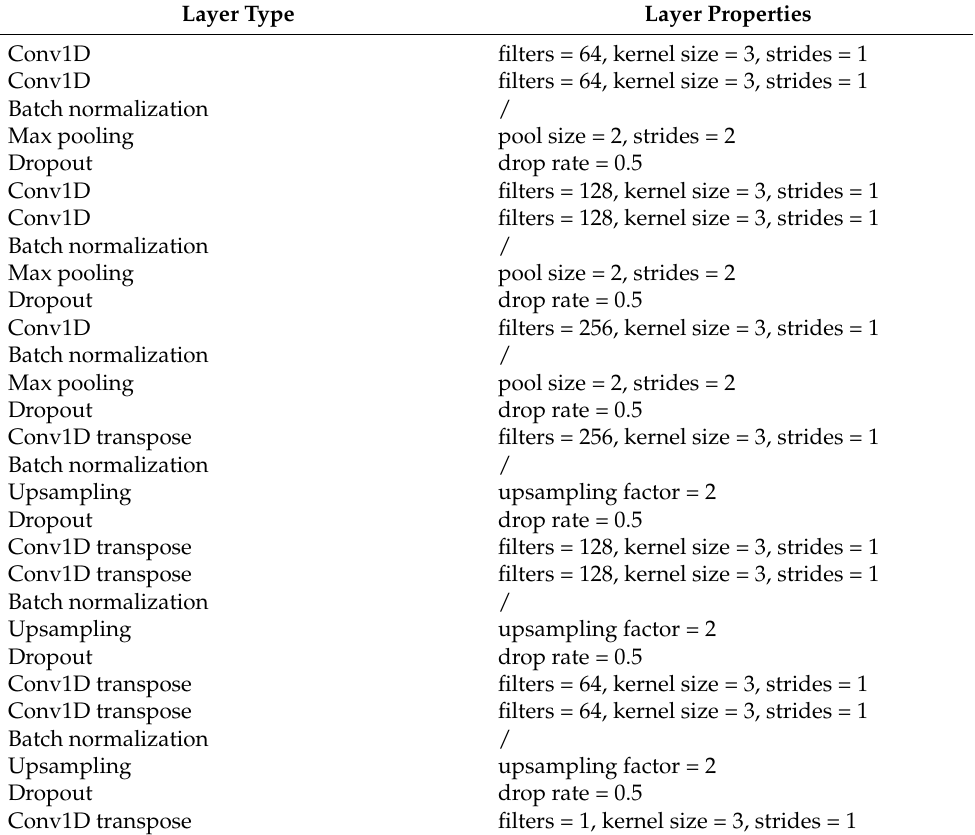
Table 1. Convolutional network